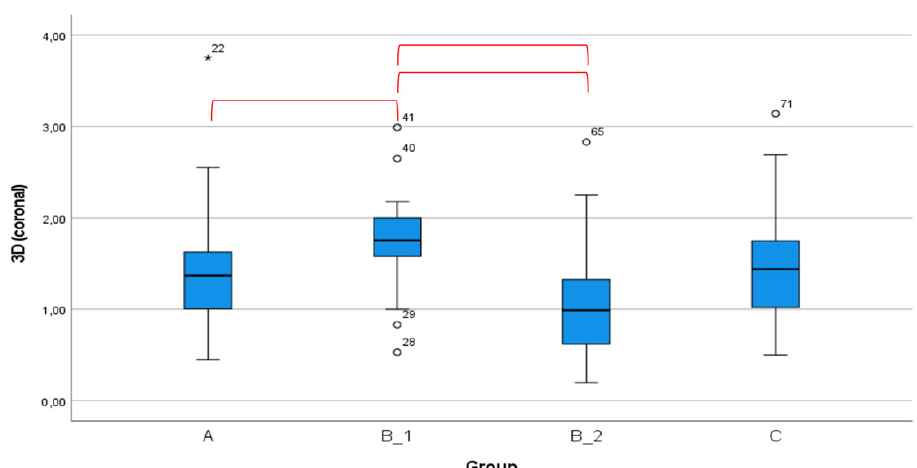
Figure 7. The global 3D deviations at the coronal exit point achieved by each process chain. The 3D deviations at the coronal exit point are significantly different between the B-1 process chain and the A, B_2, and C process chains. Statistical significance was determined using the Mann–Whitney U test. The red lines indicate significant group